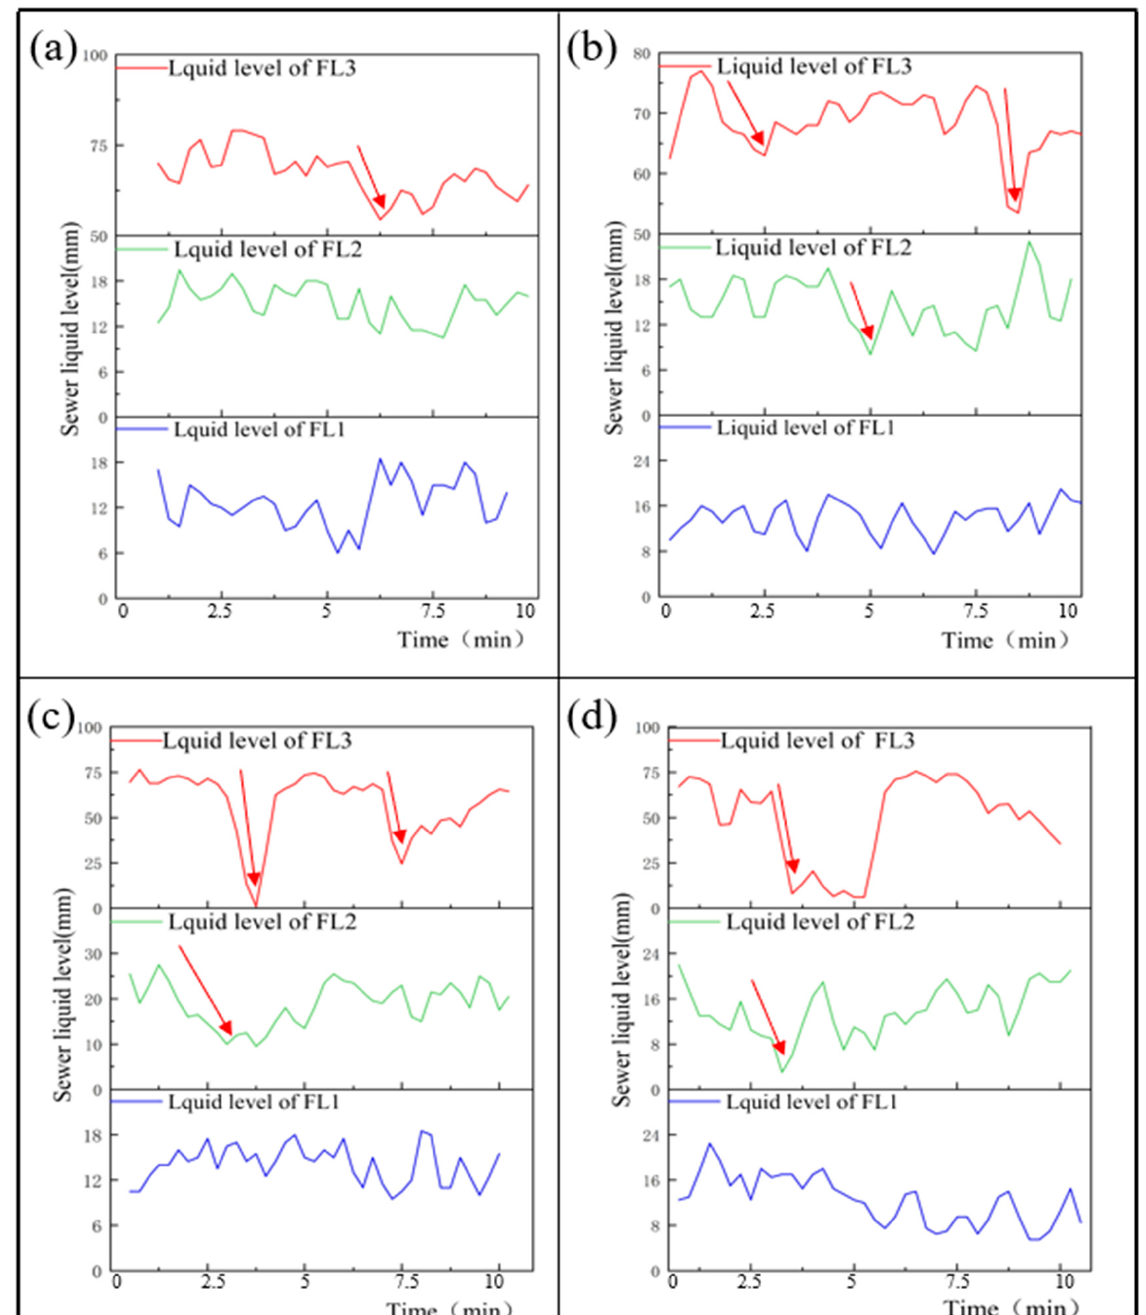
Figure 8. Change in the liquid level upstream and downstream of the DN300 sewer blocking point during the peak water consumption. ( a ) The upstream and downstream liquid level change of the blocking point when the DN300 sewer was blocked at FW1. ( b ) The upstream and downstream liquid level change of the blocking point when the DN300 sewer was blocked at FW2. ( c ) The upstream and downstream liquid level change of the blocking point when the DN300 sewer was blocked at FW3. ( d ) The upstream and downstream liquid level change of the blocking point when the DN300 sewer was blocked at FW4. The arrows are pointing at when blockage happened.